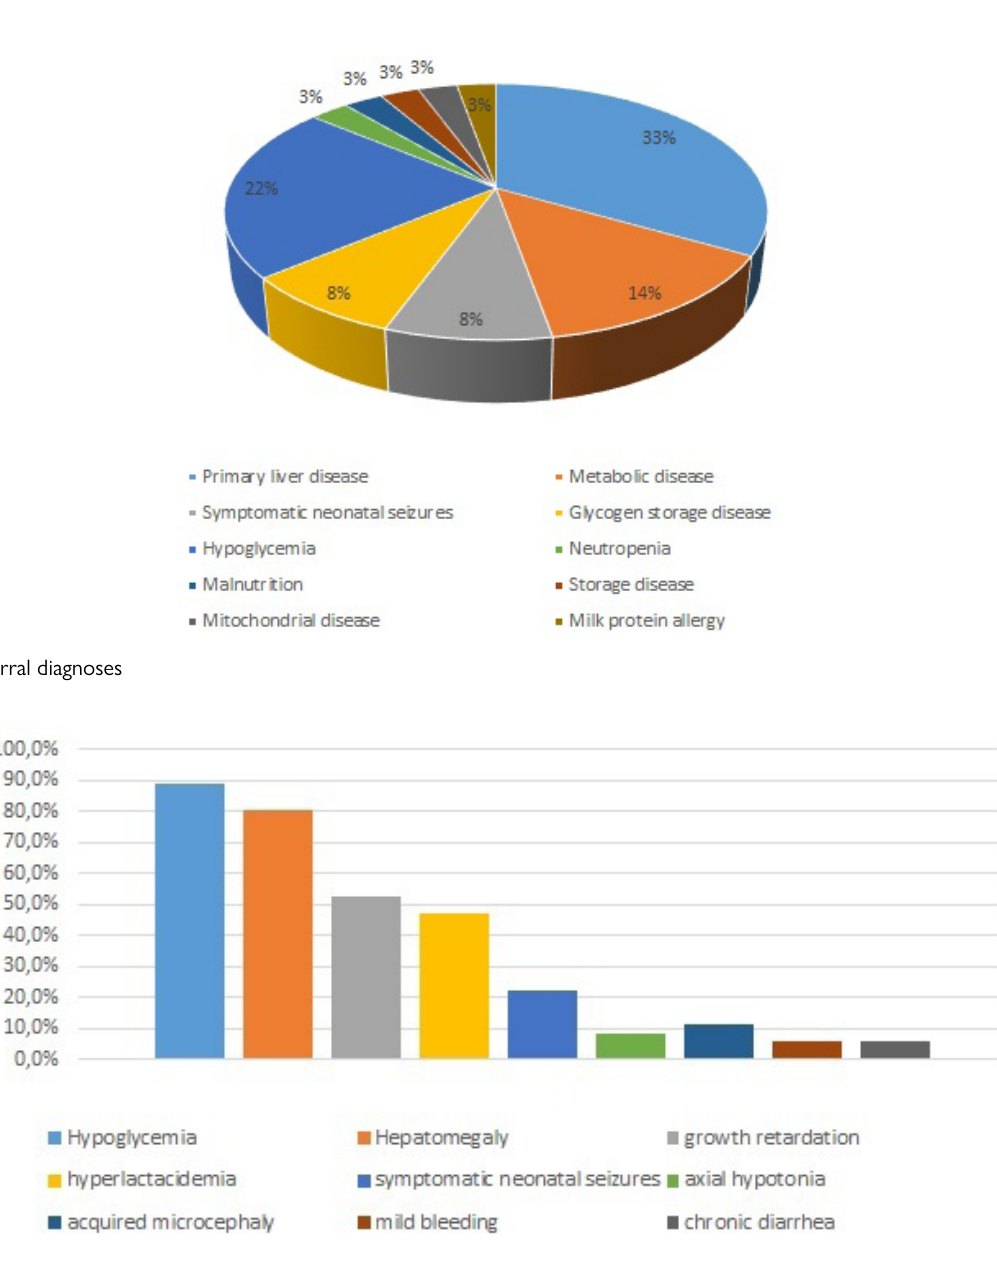
Figure 2. Initial clinical features: signs and symptoms.